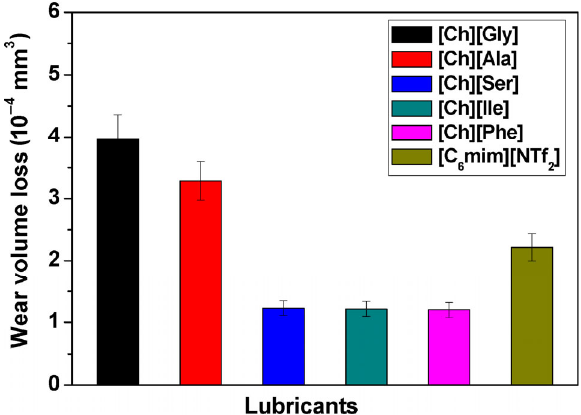
Fig. 5 Evolution of the wear volume loss of steel discs lubricated with [Ch][AA] ILs and [C 6 mim][NTf 2